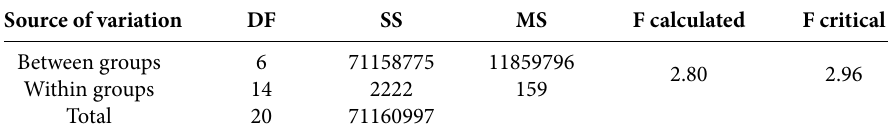
Table 2. Analysis of variance (ANOVA) for linearity